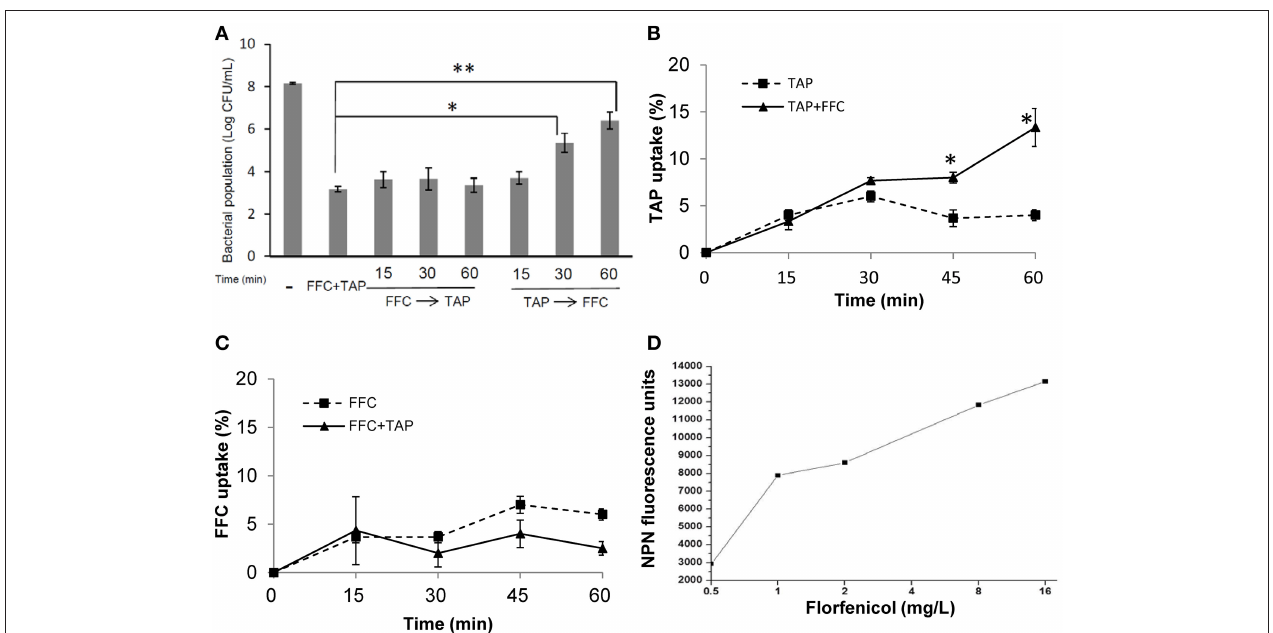
FIGURE 4 | Facilitated uptake of thiamphenicol (TAP) by florfenicol (FFC). (A) Killing rates of florfenicol (FFC) and thiamphenicol (TAP) in different mixing times against P. multocida . Time indicates minutes FFC was added prior to (FFC → TAP) or after (TAP → FFC) TAP addition. (-) represented the control culture without addition of antibiotics. Bacteria populations were counted at 24 h and compared using one way ANOVA and Tukey’s test for multiple comparisons. P values of less than 0.05 were considered significant. Statistical significance is presented as ** P < 0.01, or * P < 0.05. (B) Uptake of TAP (depletion in medium) presented as a percentage of the initial concentration: 256 mg/L on P. multocida . The concentration of FFC was 8 mg/L. The data shown are the means ± SE of three independent experiments and were analyzed using Student’s t -test. ( * P < 0.05). (C) Uptake of FFC presented as a percentage of the initial concentration: 8 mg/L on P. multocida . The concentration of TAP was 256 mg/L. (D) Permeability of P. multocida was evaluated by measuring the 1- N -phenylnaphthylamine (NPN) at 10 min after FFC treatment at indicated concentration. The data shown are the average of triplicate experiments. The deviations between triplicate data point were < 5%.